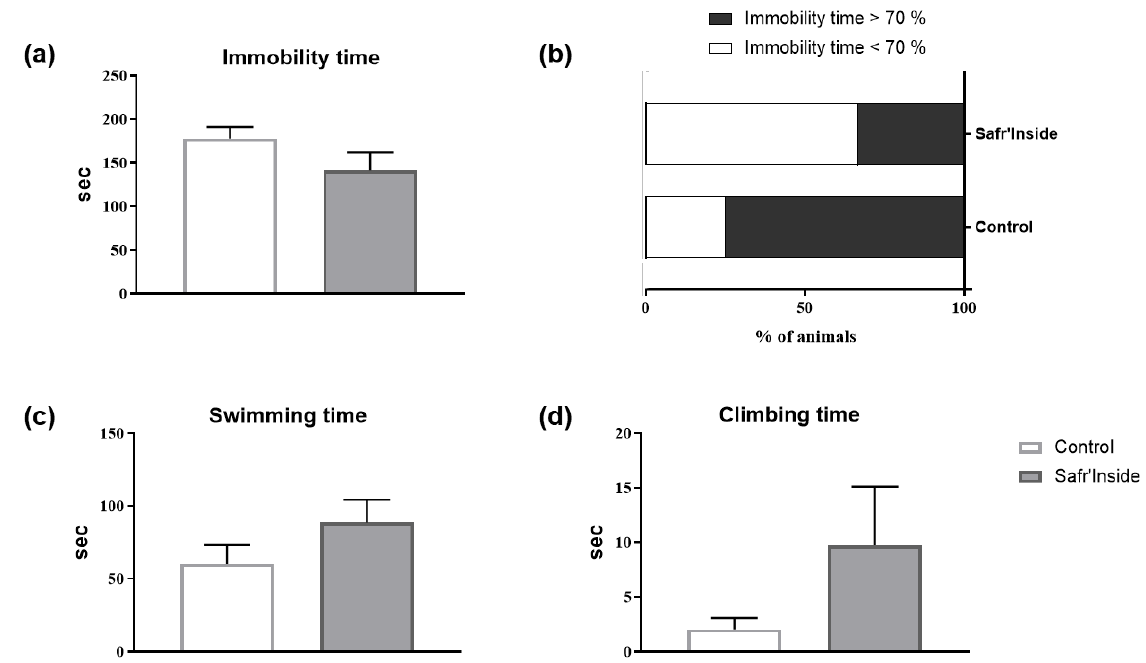
Figure 4. Effect of chronic oral administration of Safr’Inside TM (6.25 mg/Kg) on depressive-like behavior measured in the FST. ( a ) Immobility time; ( b ) Index of immobility; ( c ) Swimming time and ( d ) Climbing time. FST has been conducted after 4 weeks of treatment and 3 h after the last gavage. Results are shown as mean ± SEM. Control (Water): n = 8; Safr’Inside: n = 9.